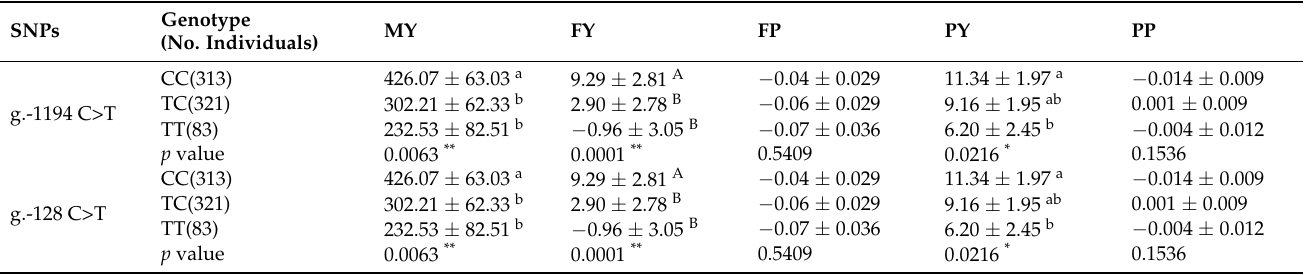
Table 1. Associations of the two SNPs in the DDIT3 gene with the five traits (LSM ± SE). Genotype SNPs (No.